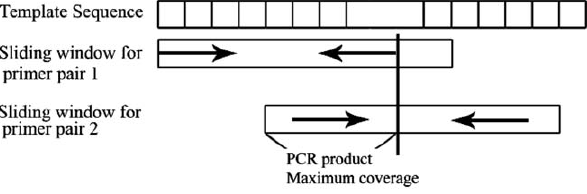
Figure 4. Illustration of the sliding window-based PSO algorithm for primer design. The arrow lines indicate the forward and reverse primers.